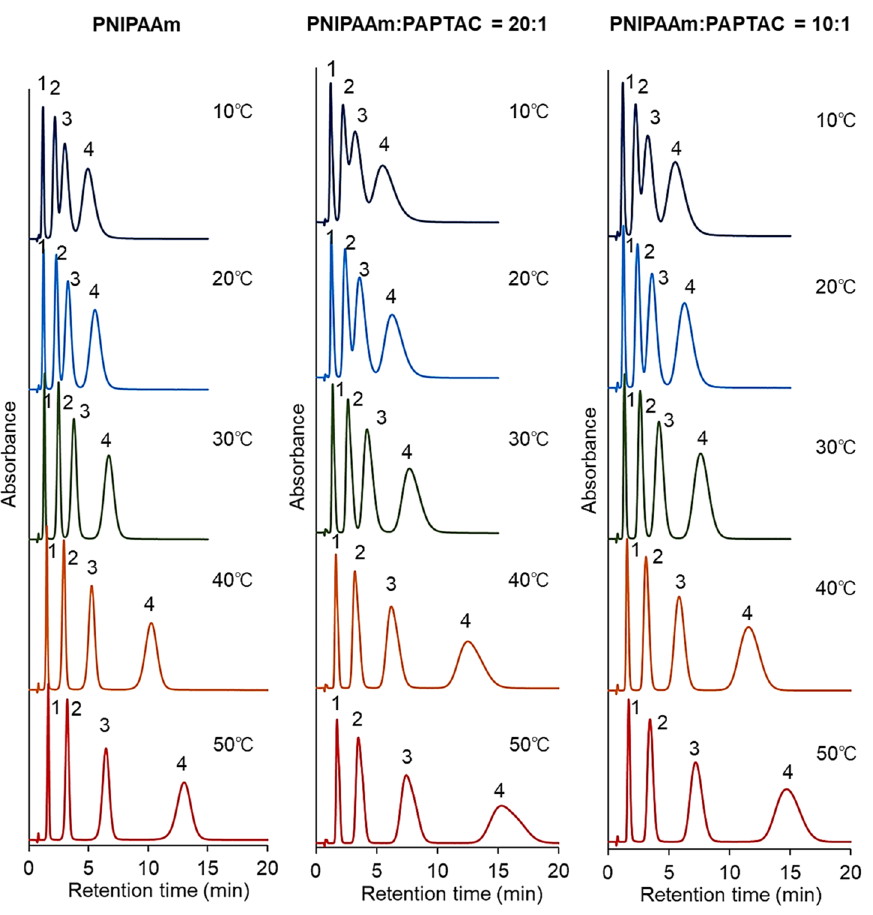
Figure 5. Chromatograms of the antiepileptic drugs on the prepared mixed-mode columns. The mobile phase is 10 mM CH